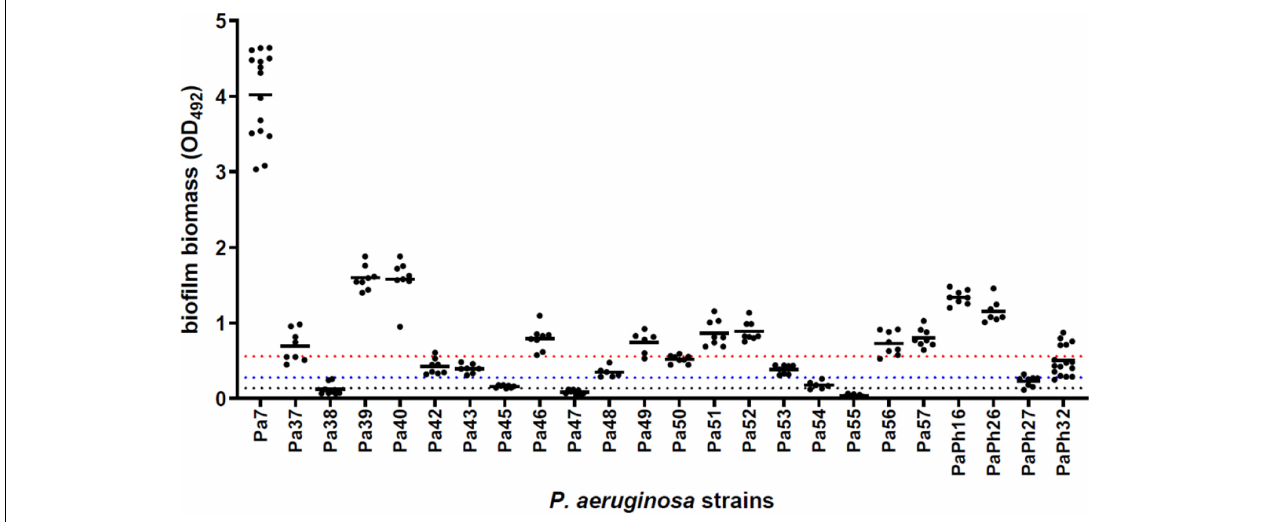
FIGURE 3 | Biofilm formation by P. aeruginosa strains from CF patients. The amount of biofilm formed following 24 h-incubation at 37 ◦ C was measured in polystyrene 96-well microtiter plate using the crystal violet assay. Results are shown as scatter plot, with the horizontal solid line indicating the mean OD value. According to the criteria proposed by Stepanovi´c et al. (2007) a strain was classified for biofilm formation as follows: non-producer (OD ≤ OD c ; below the dotted black line); weak-producer [OD c < OD ≤ (2 × OD c ); between dotted black and blue lines]; moderate-producer [(2 × OD c ) < OD ≤ (4 × OD c ); between dotted blue and red lines]; or strong-producer (OD > 4 × OD c ; above the dotted red line). Cut-off value (OD c ) was defined as the mean OD of negative control + 3 ×